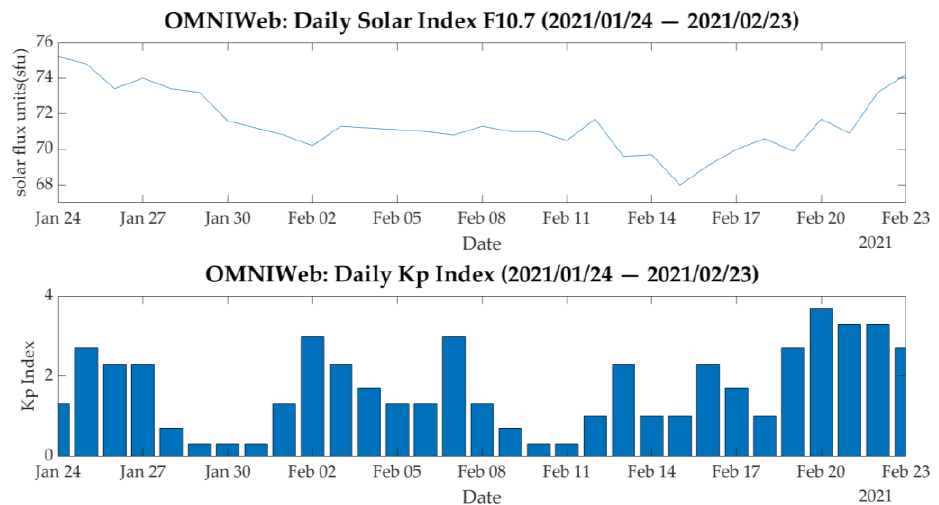
Figure 26. F10.7 solar activity index (top) and Kp geomagnetic disturbance index (bottom) from launch to 23 February.